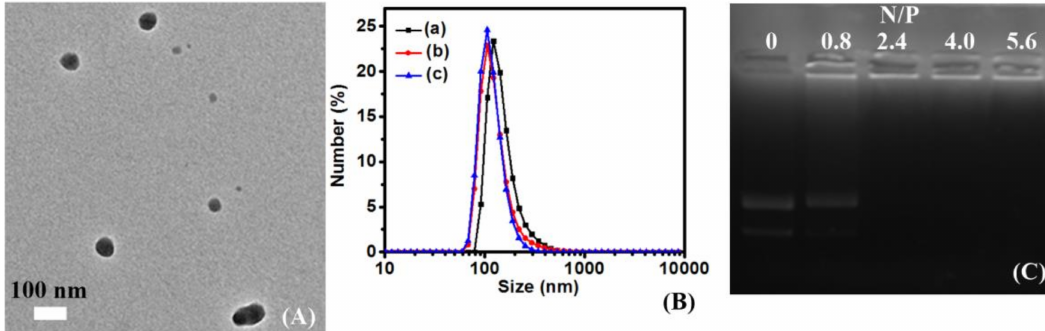
Figure 4. Self-assembling of pDNA and polypeptides: ( A ) transmission electron microscopy of poly( L -lysine) 50 - block -poly( L -leucine) 15 /pDNA at the N/P = 15; ( B ) DLS of (a) poly( L -lysine) 50 - block - poly( L -leucine) 25 , (b) poly( L -lysine) 50 - block -poly( L -leucine) 15 , and (c) poly( L -lysine) 50 - block - poly( L -leucine) 10 mixed with pDNA at the N/P = 15; and ( C ) agarose gel electrophoresis of poly( L -lysine) 50 - block -poly( L -leucine) 15 /pDNA at various N/P